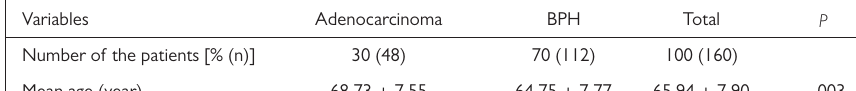
Table 1. Demographical/Physical Examination Results and the Mean PSA and Prostate Volumes of the Patients Variables